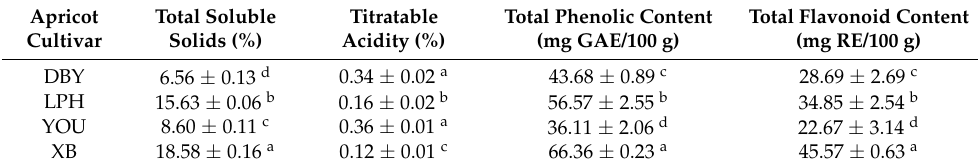
Table 1. Fundamental physicochemical properties in four different apricot cultivars. Apricot